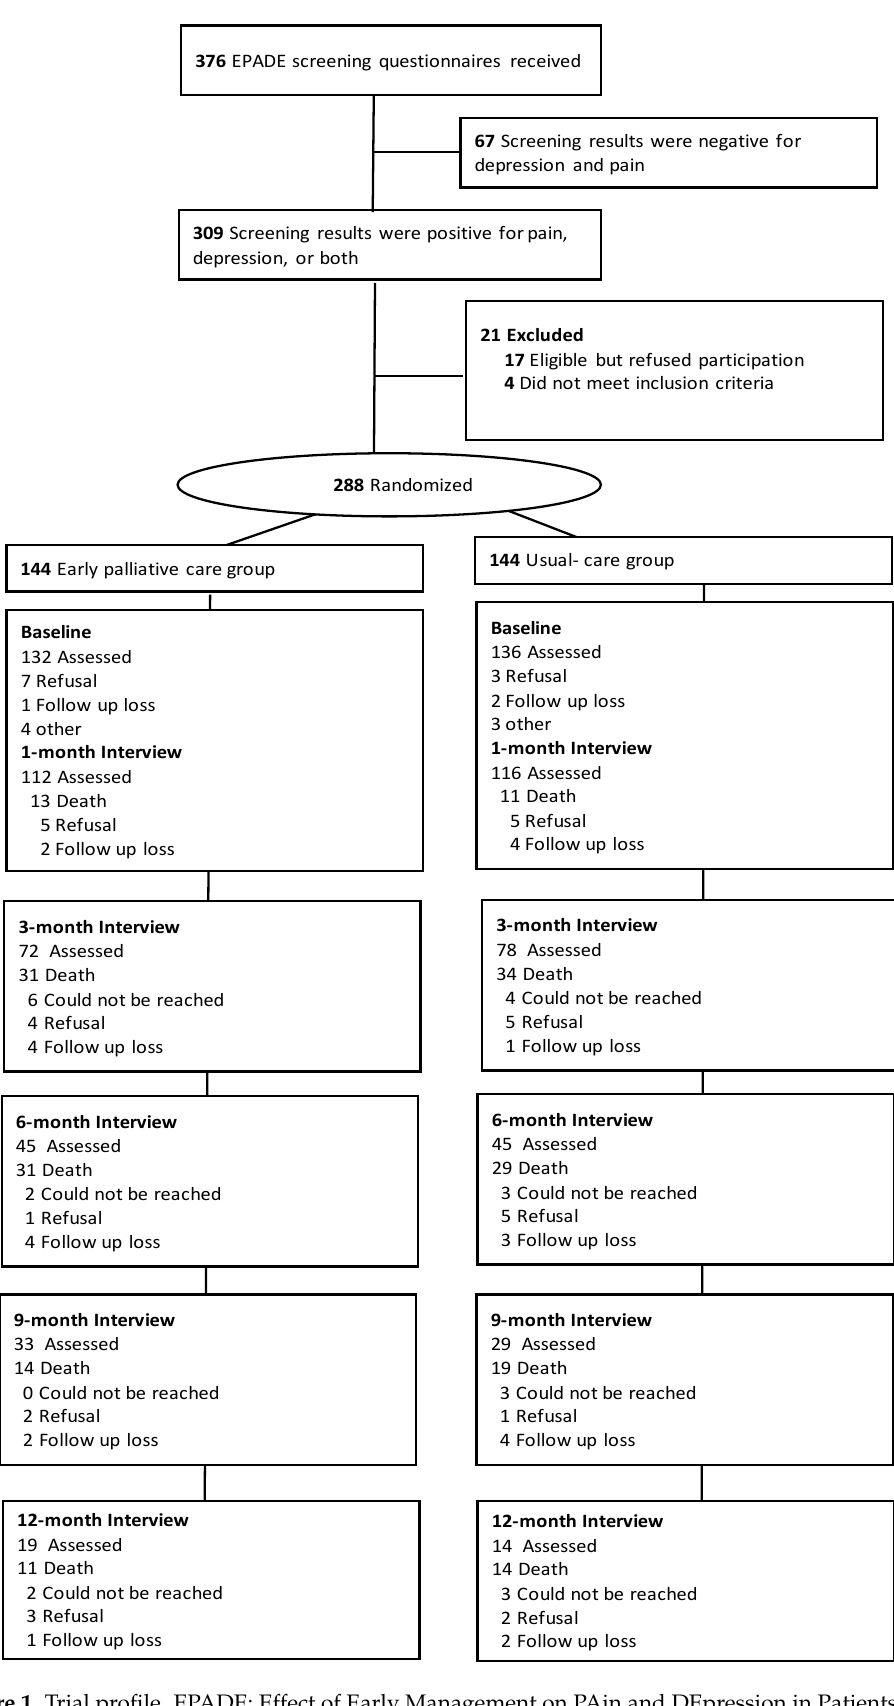
Figure 1. Trial profile. EPADE: Effect of Early Management on PAin and DEpression in Patients with PancreatoBiliary